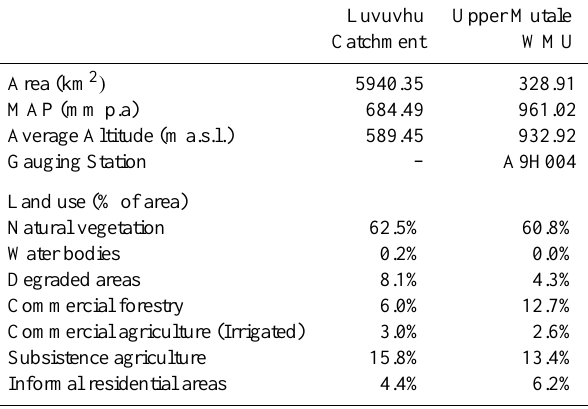
Table 3. Summary of selected features and land uses of the Luvu- vhu Catchment and the Upper Mutale WMU.